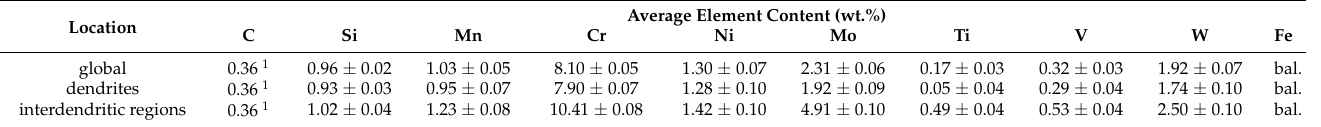
Table 5. EDS measurements in the microstructure of a single layer weld of tool steel X36. Average Element Content (wt.%) Location C